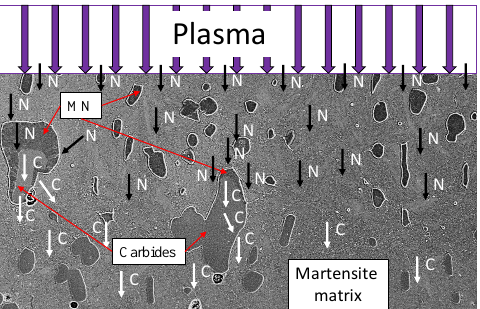
Figure 1. Schematic model of in situ precipitation of MN nitrides on M 7 C 3 carbides during plasma nitriding of the X153CrMoV12 tool steel, adapted from [28].